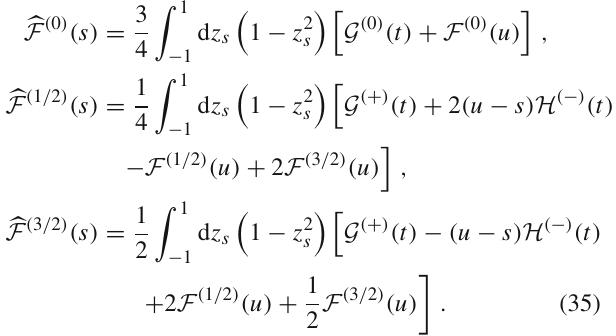
Fig. 4. Along the right-hand cut, the corresponding unitarity